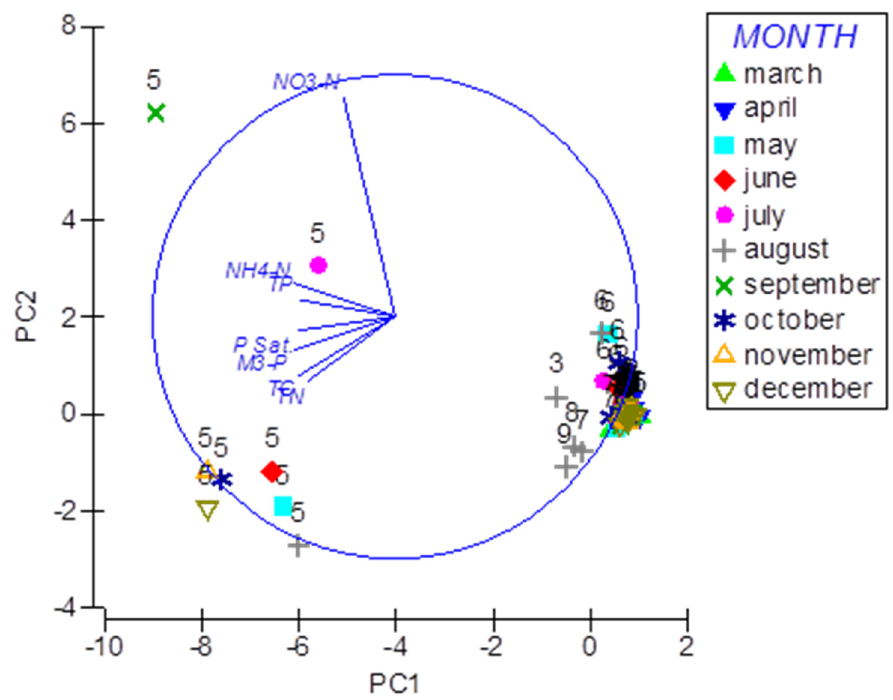
Figure 5. Principal component analysis (PCA) plot for Site I soil samples including the manure pile (sample 5).